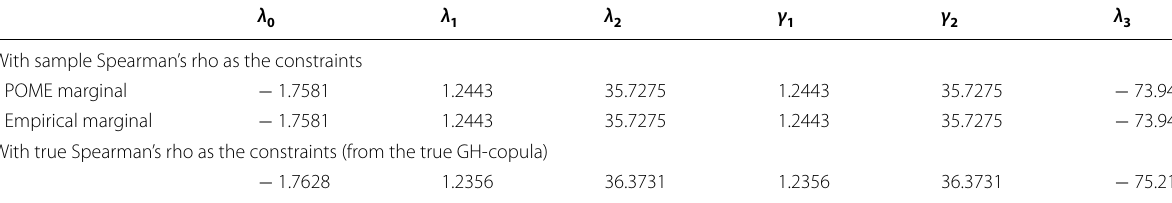
Italic values indicate the best fitted copula function under each condition a Entropy computed from the parametric copula using Eq. (40). The copula with the largest absolute value is the best copula candidate Table 5 Parameters estimated for MECC copula λ